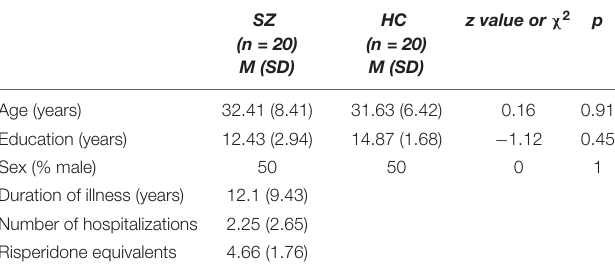
TABLE 1 | Demographic and clinical data of research